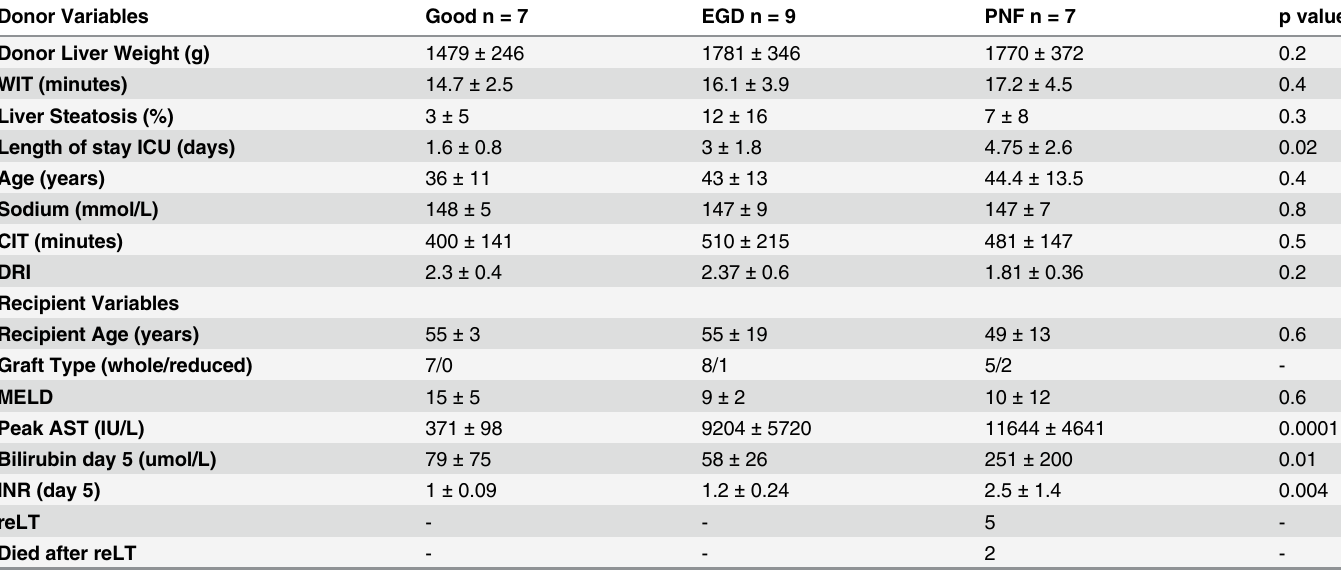
Summary of recipient and donor clinical information in the three donation after cardiac death (DCD) liver groups of good, early graft dysfunction (EGD) and primary non function (PNF). Abbreviations g (grams), WIT (warm ischemic time), ICU (intensive care unit), CIT (cold ischemic time), DRI (donor risk index), MELD (model for end stage liver disease), AST (serum aspartate transaminase IU/L), INR (international normalised ratio), reLT (redo liver transplant). Where appropriate data expressed as mean and standard